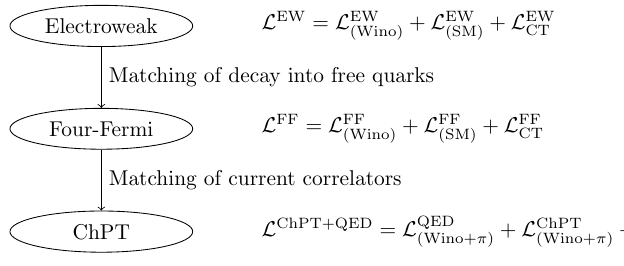
Figure 2 . Flowchart of the matching